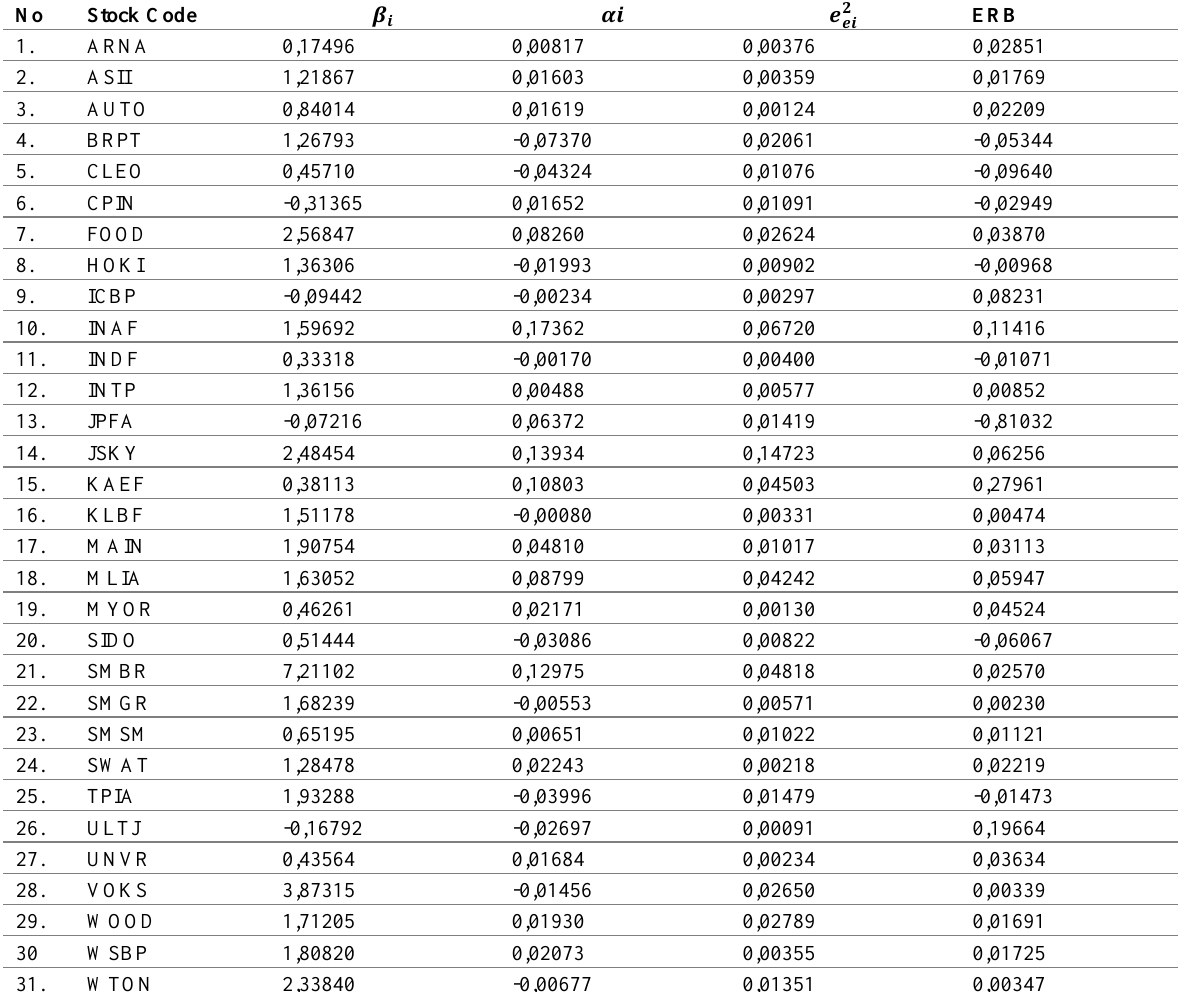
Table 3: Beta , Variance Error Residual , Alpha , and Excess return to beta